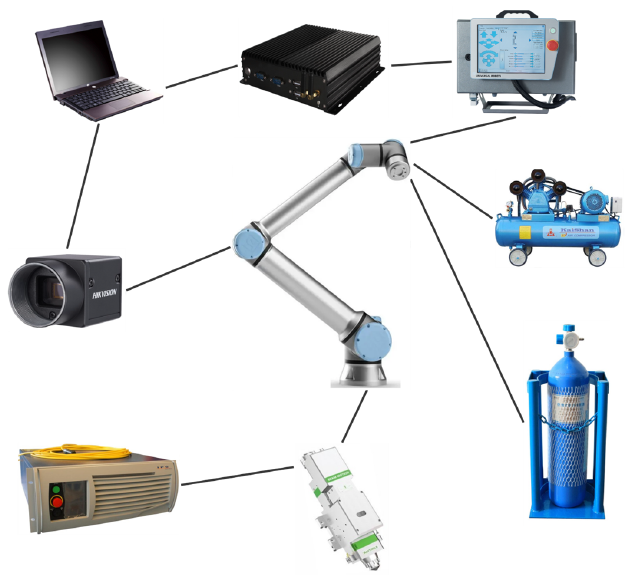
Figure 2. The weld positioning system.